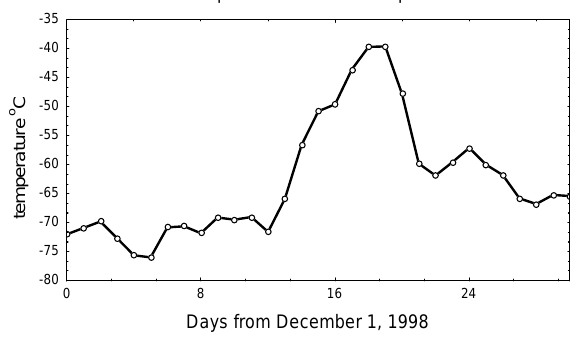
Fig. 11a. S-transform results for the December 1998 campaign. Results of tidal amplitudes for Obninsk data (top panel). Cross-S-transform results between the tidal amplitudes of Shrivenham and Kazan (middle panel). In the lowermost panel the 30 hPa temperature above the pole is